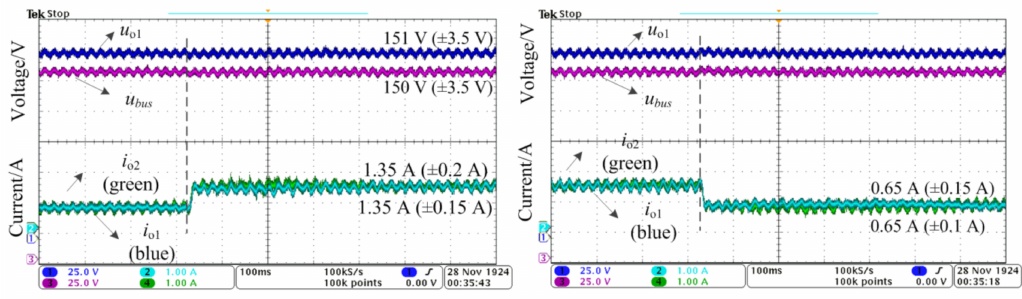
Figure 16. Experimental results of two parallel converters with equal rating under the dc / dc power-converter-based